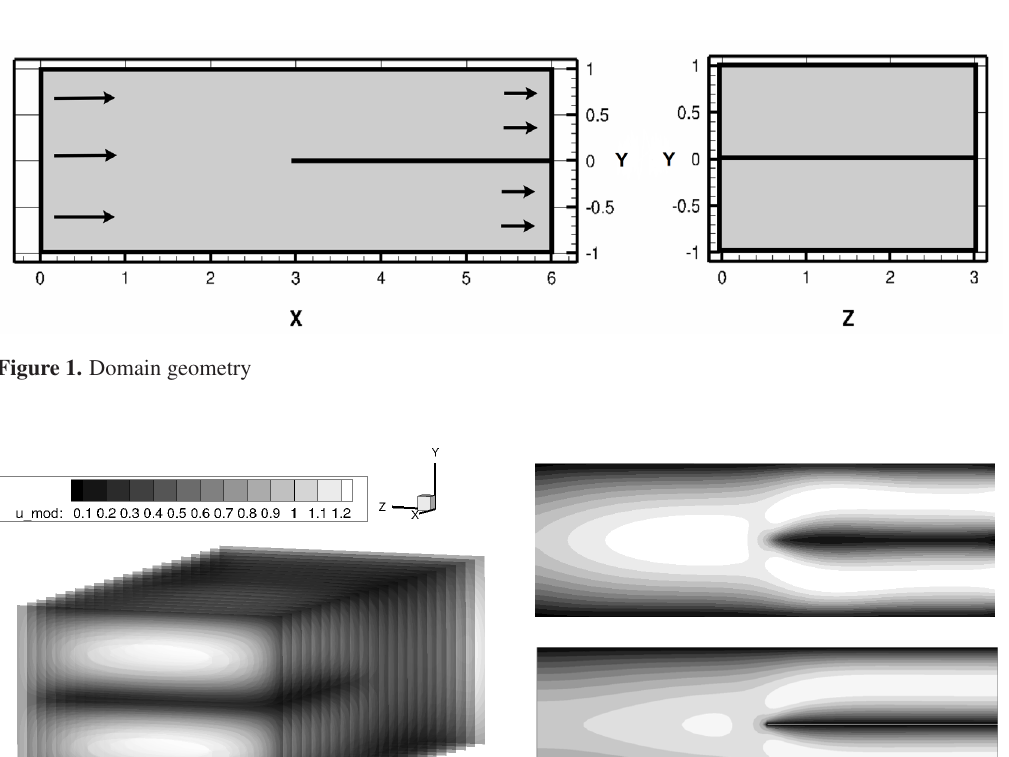
the walls are set. At the same time, part of the reservoir (from 0.0 to 2.9 in the X direction) is under the influence of the induced electromagnetic field in the positive direction of the Z -axis. Due to this separation, the liquid saturated with impurities flows from the lower outlet. The purified liquid flows